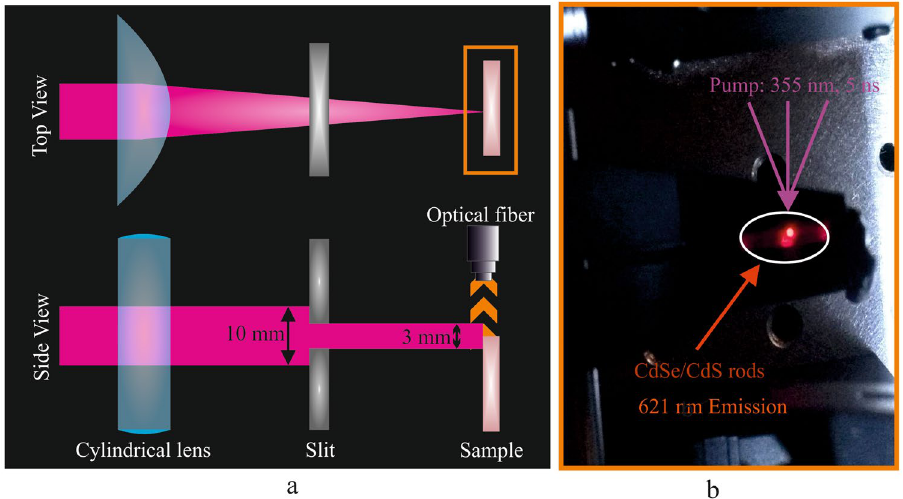
Figure 1. ( a ) Schematic diagram of the experimental set up, containing a laser beam focused by a cylindrical lens from top view and side view (with a metal slit fully opened) to control the focus length on a sample. The photoluminescence is measured by positioning an optical fiber perpendicularly, close to the edge of the film. ( b ) Experimental photo of CdSe/CdS rods, excited with 355 nm (6 ns) laser. The photo shows a view onto the upper edge of the sample. The bright spot inside the white circle is the ASE from the pumped zone, demonstrating the strong emission and amplification